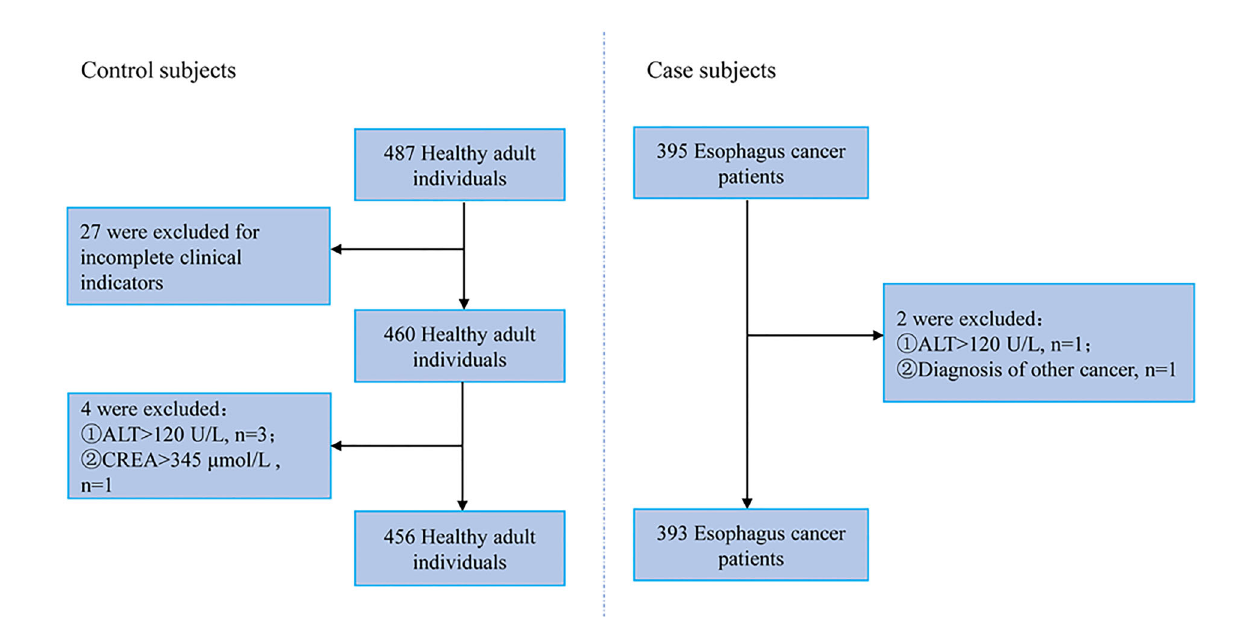
FIGURE 1 | Work fl ow of sample